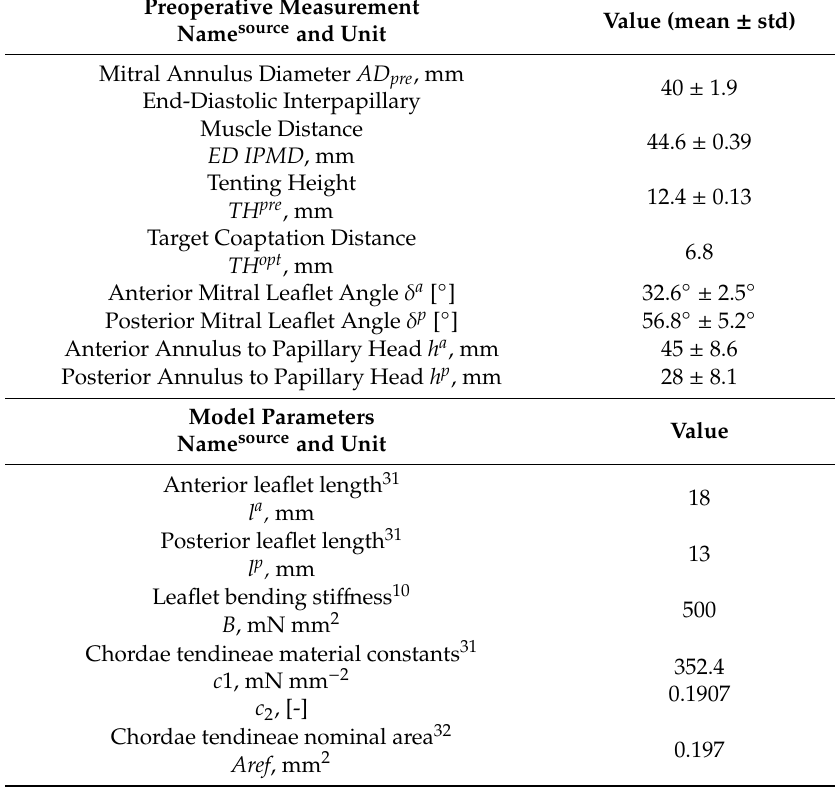
Table 1. Preoperative geometrical measurements and constitutive parameters, adapted from